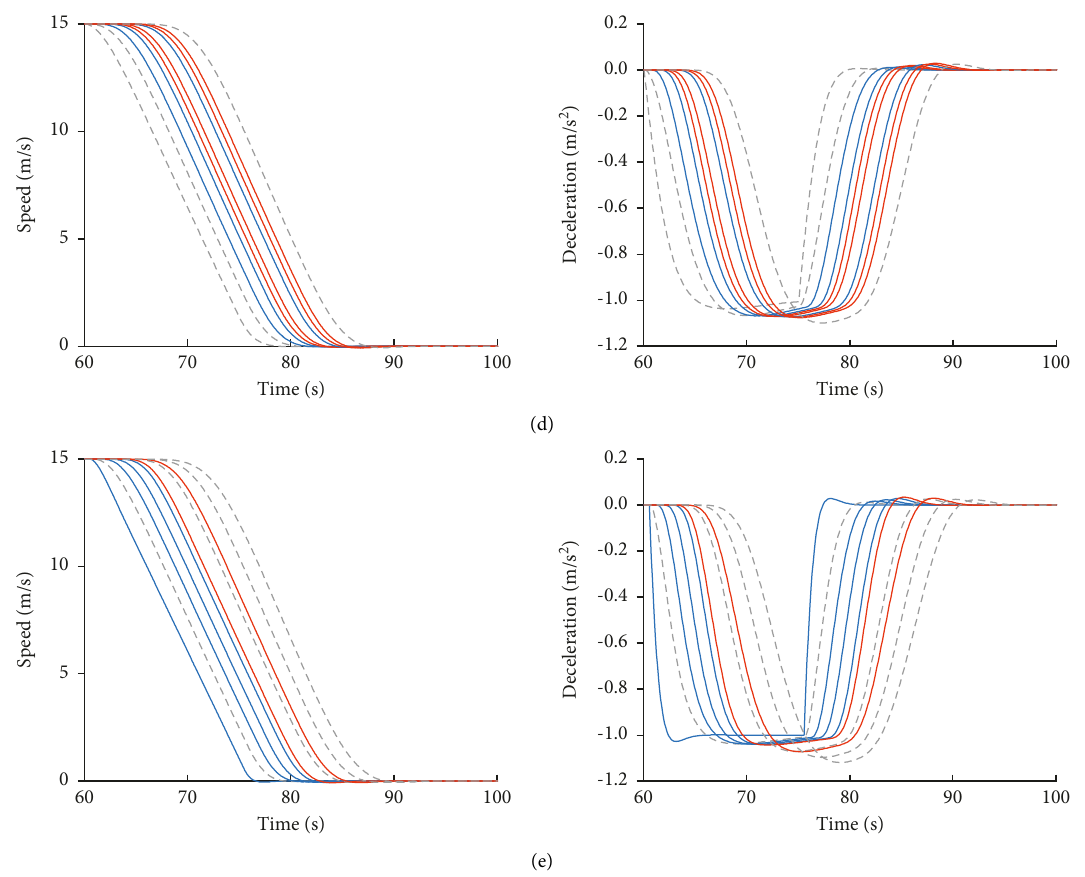
Figure 7: Vehicle dynamics with transmission delay during braking case. (a) p � 0. (b) p � 0 . 2. (c) p � 0 . 4. (d) p � 0 . 6. (e) p � 0 .